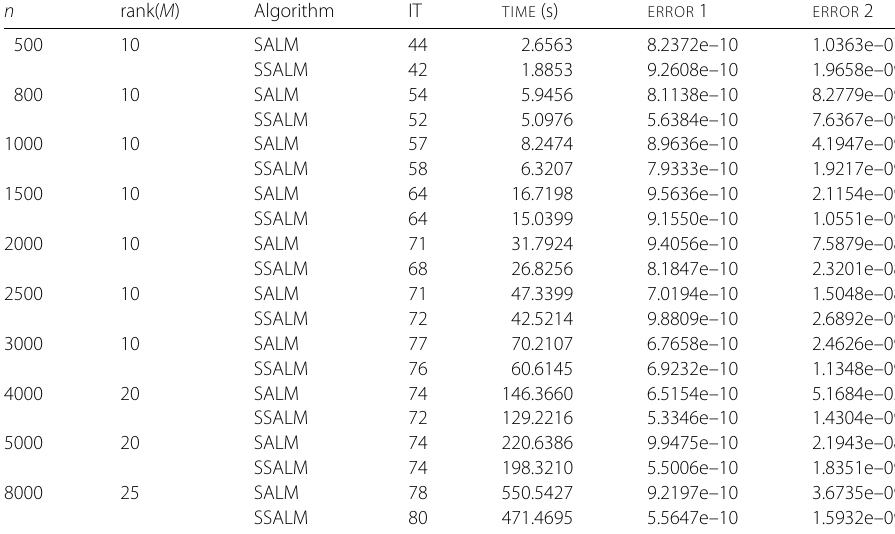
Table 1 Comparison between SALM and SSALM for p = 0.6